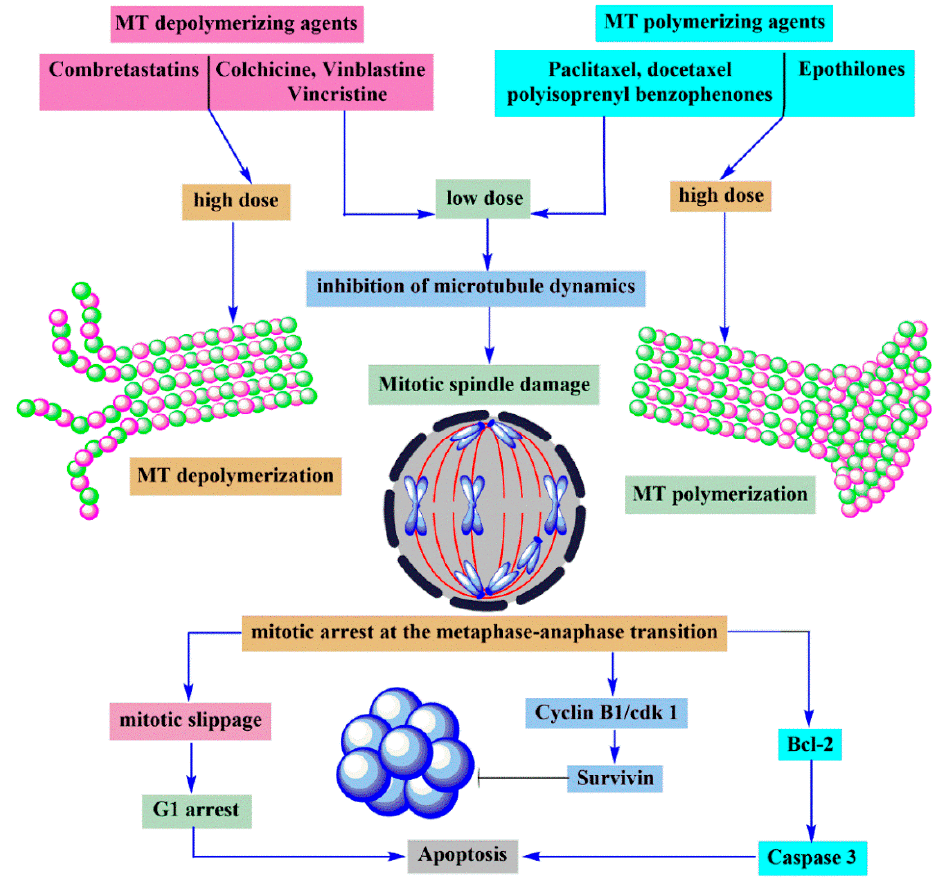
Figure 9. Schematic describing proposed mechanism of action of the different periods of microtubule targeting agents. At high dose combretastatins, colchicine, vincristine and vinblastine induce microtubule depolymerization, while paclitaxel, docetaxel, polyisoprenyl benzophenones and epothilones promote microtubule polymerization; at low dose, all microtubule-binding agents inhibit microtubule dynamics, prevent the proper alignment of chromosomes at the metaphase plate and segregation of chromosomes in anaphase, leading to mitotic arrest and apoptosis.